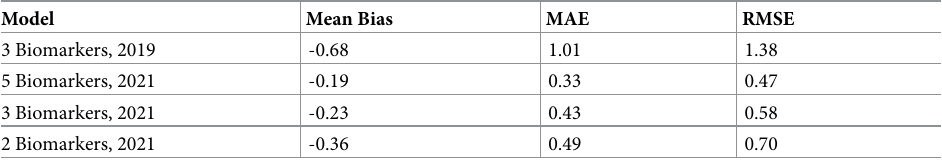
Table 1. Biomarker model performance.